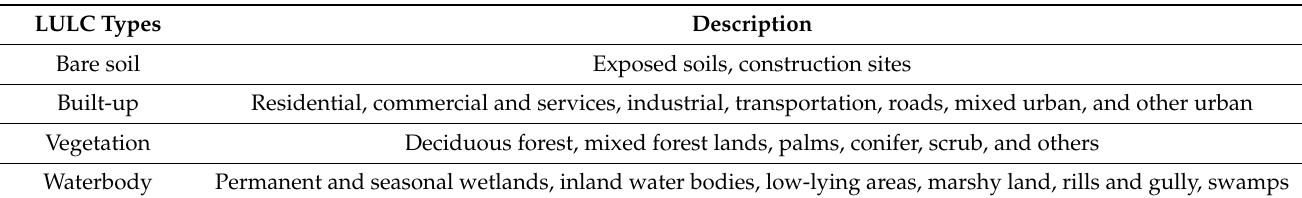
Table 2. Land cover classes developed in this